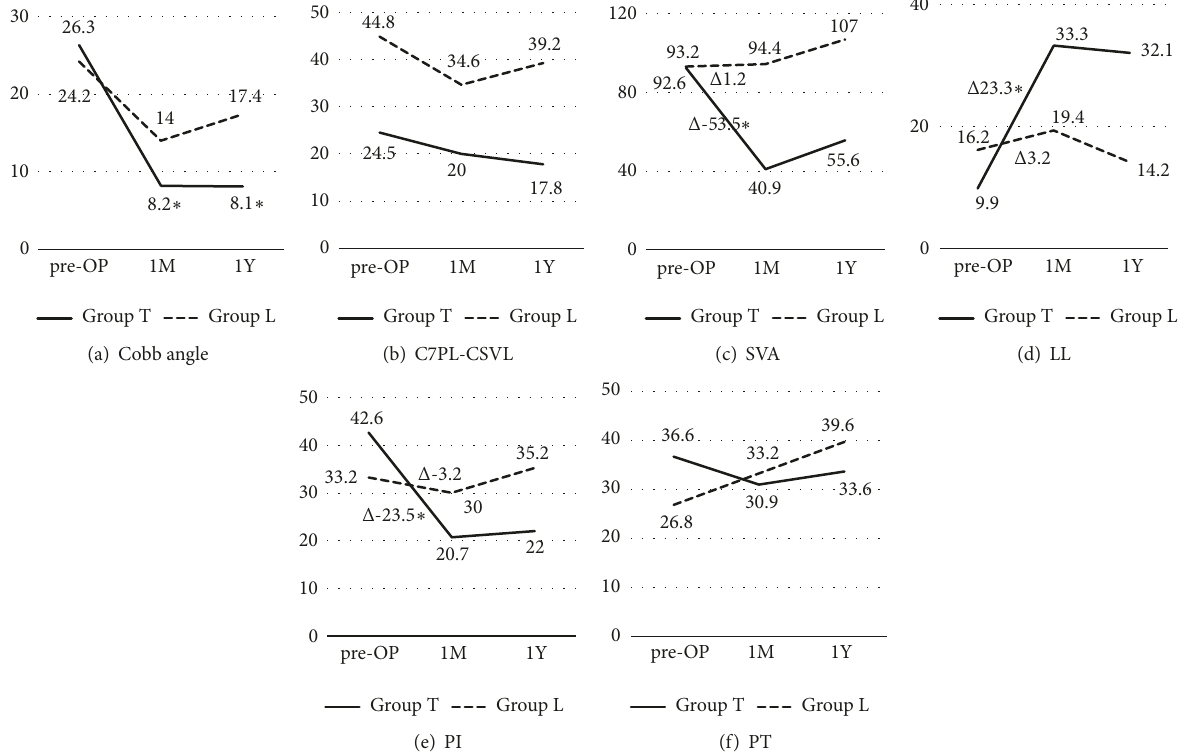
Figure 3: Mean values of radiological measurements at preoperative, 1 month after the surgery and 1 year of (a) Cobb angle, (b) C7PL-CSVL= C7 plum line, central sacral vertical line, (c) SVA = Sagittal vertical axis, (d) LL = lumbar lordosis, and (e) PI = Pelvic incidence. (f) PT = pelvic tilt. ∗ Difference is significant compared to group